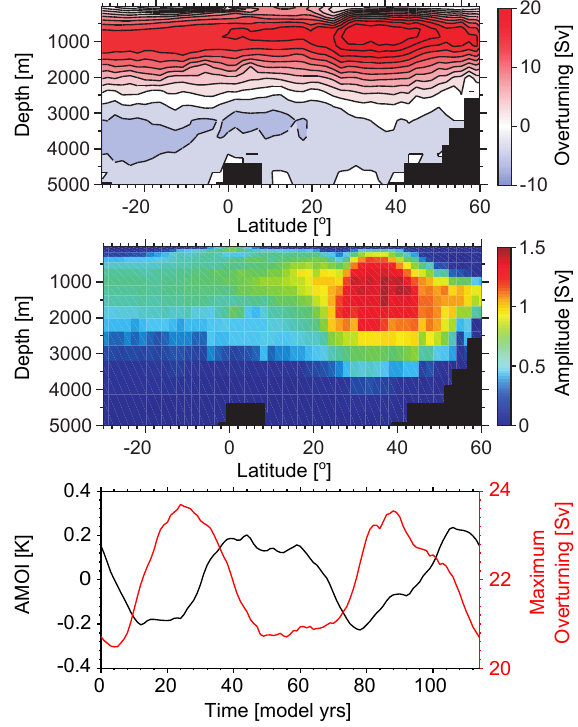
Fig. 2. (Top) Annual mean meridional overturning streamfunction for the Atlantic obtained from the control run with no AMO-like forcing. (Middle) Amplitude of the leading complex empirical or- thogonal function, showing the amplitude of the variability induced in the AMOC by the AMO-like forcing. (Bottom) Variations in modelled AMO index and the maximum of the meridional over- turning streamfunction for the Atlantic resulting from the AMO-like